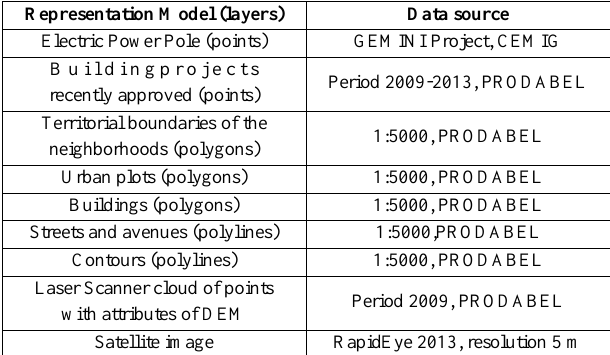
Table 1 Data sources for the Representation Model in geodesign for urban planning (Cocco et al.,